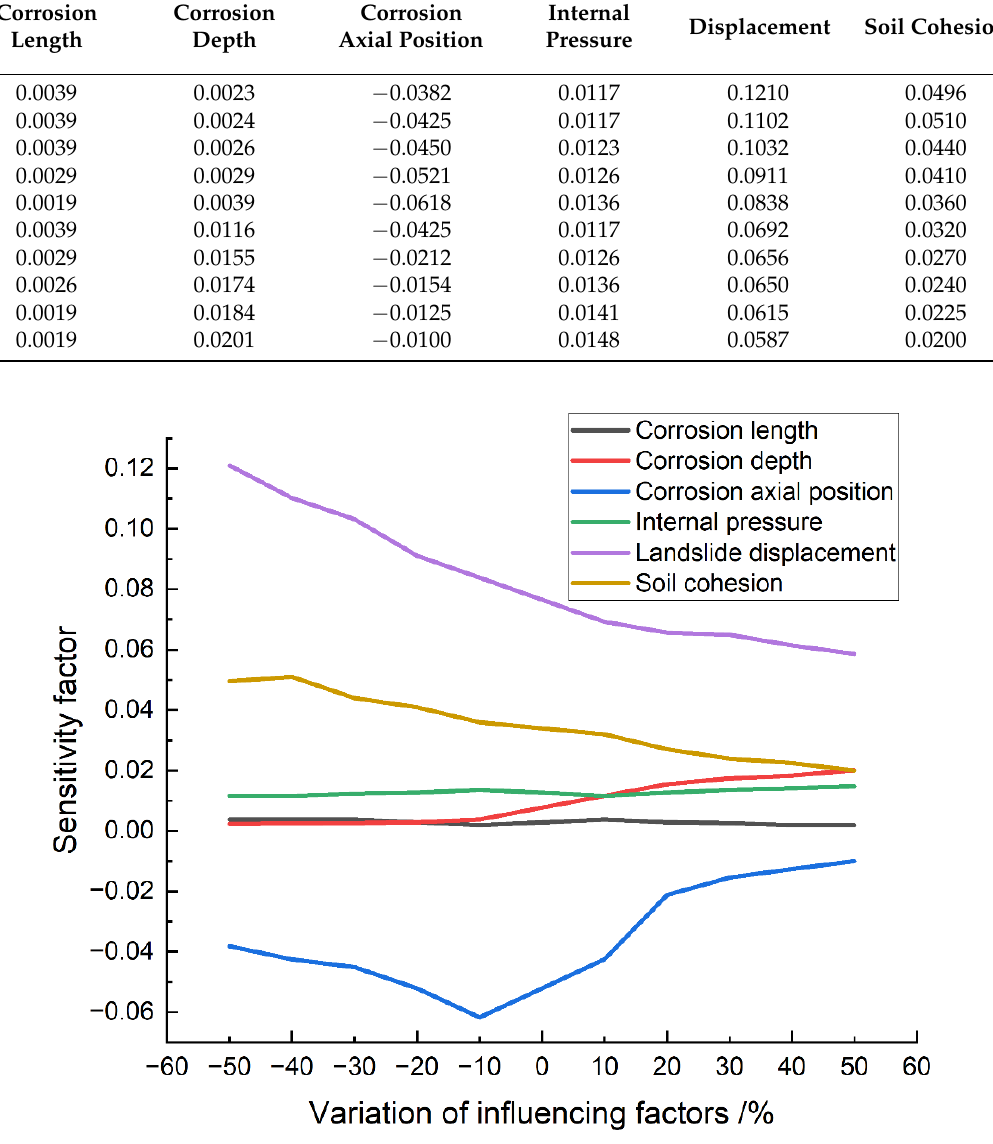
Figure 13. Variation diagram of sensitivity coefficient.